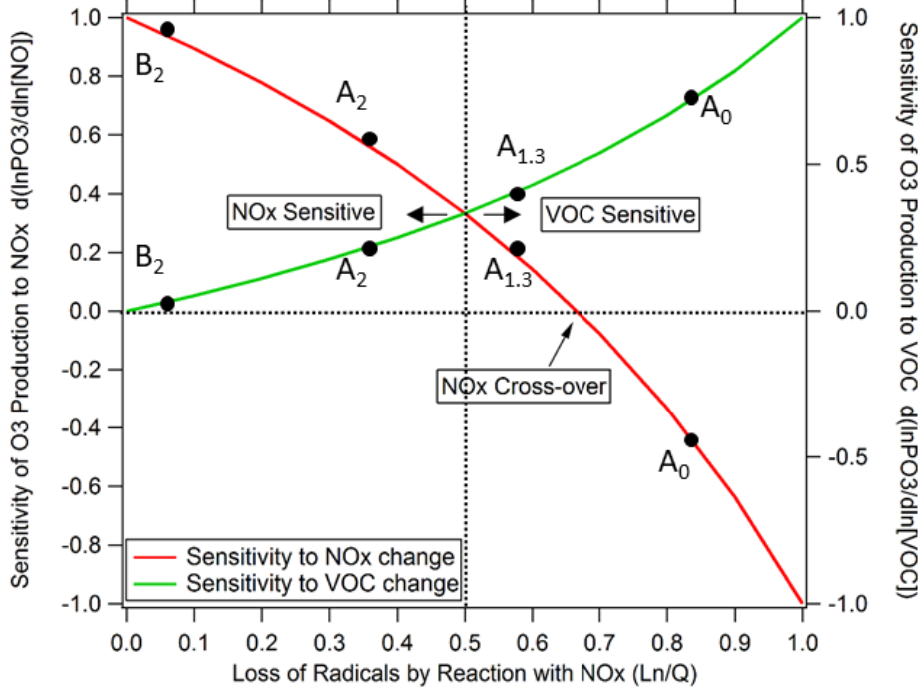
Figure 17. Sensitivity of ozone production to changes in precursor concentrations (a value of + 1.0 means that a 10% increase in precursor concentration (e.g., NO x , red curve) results in a 10% increase in ozone production, a value of + 0.5 means that a 10% increase in precursor concentrations results in a 5% increase in the ozone production rate, a value of − 0.5 means that a 10% increase in precursor concentrations results in a − 5% decrease in ozone production rate). The right axis is the sensitivity to changes in volatile organic compound (VOC) concentrations (green curve). The points represent positions along the lake-breeze circulation (A 0 is surface over North Toronto, A 1.3 is at 1.3-km altitude over North Toronto, A 2 represents 2-km altitude over North Toronto and B 2 represents 2-km altitude over Uptown Toronto).